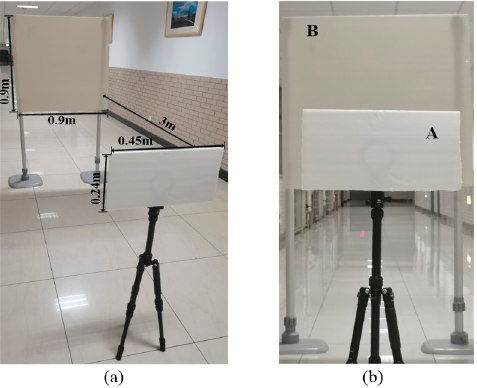
Figure 9. Imaged targets. ( a ) Relative location of two plates. ( b ) Front view of ( a ).